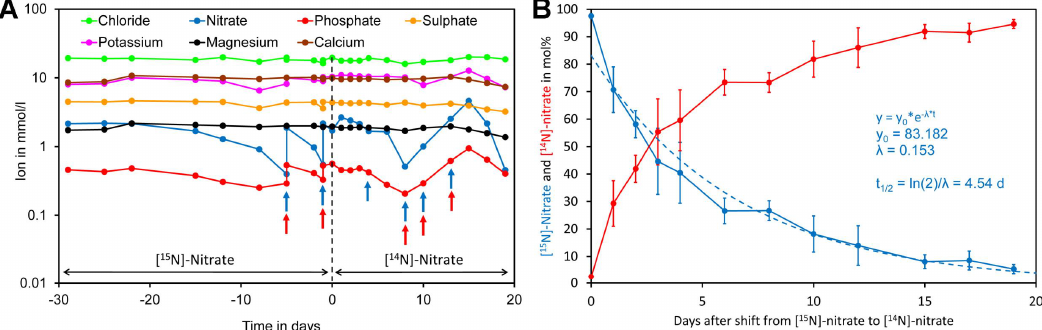
Figure 7. Kinetics of replacement of [ 15 N]-nitrate by [ 14 N]-nitrate in leaves of Crassocephalum crepidioides . ( A ) Plants were grown hydroponically in liquid medium containing [ 15 N]-nitrate as the sole nitrogen source for 29 days. Subsequently, the medium was replaced by medium containing [ 14 N]-nitrate as the sole nitrogen source (time 0, indicated by a dotted line) and grown for a further 19 days. Samples of the medium were taken at the indicated time points and analyzed for ions. If required, the medium was supplemented for nitrate by adding [ 15 N] or [ 14 N]-potassium nitrate (blue arrows) or for phosphate by adding potassium dihydrogen phosphate (red arrows). ( B ) Leaf disc samples were taken at the indicated time points for analysis of leaf [ 14 N]-nitrate and [ 15 N]-nitrate levels. The points and bars represent the biological average and standard error (SE) of samples taken from four di ff erent leaves. Total nitrate concentrations in leaf material and original data are presented in Supplementary Files S9 and